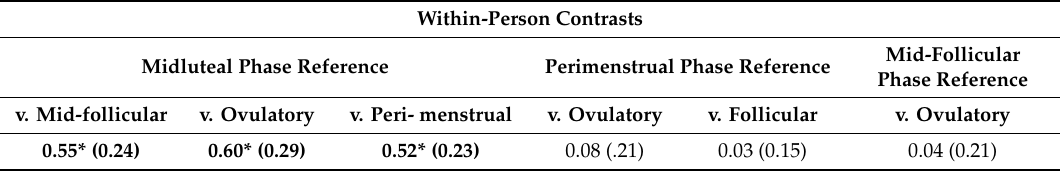
Table 2. Multilevel Regression Models Predicting Log High Frequency Heart Rate Variability (HFlog) from Menstrual Cycle Phase (Within-Person Contrasts) in Study One ( N = 105